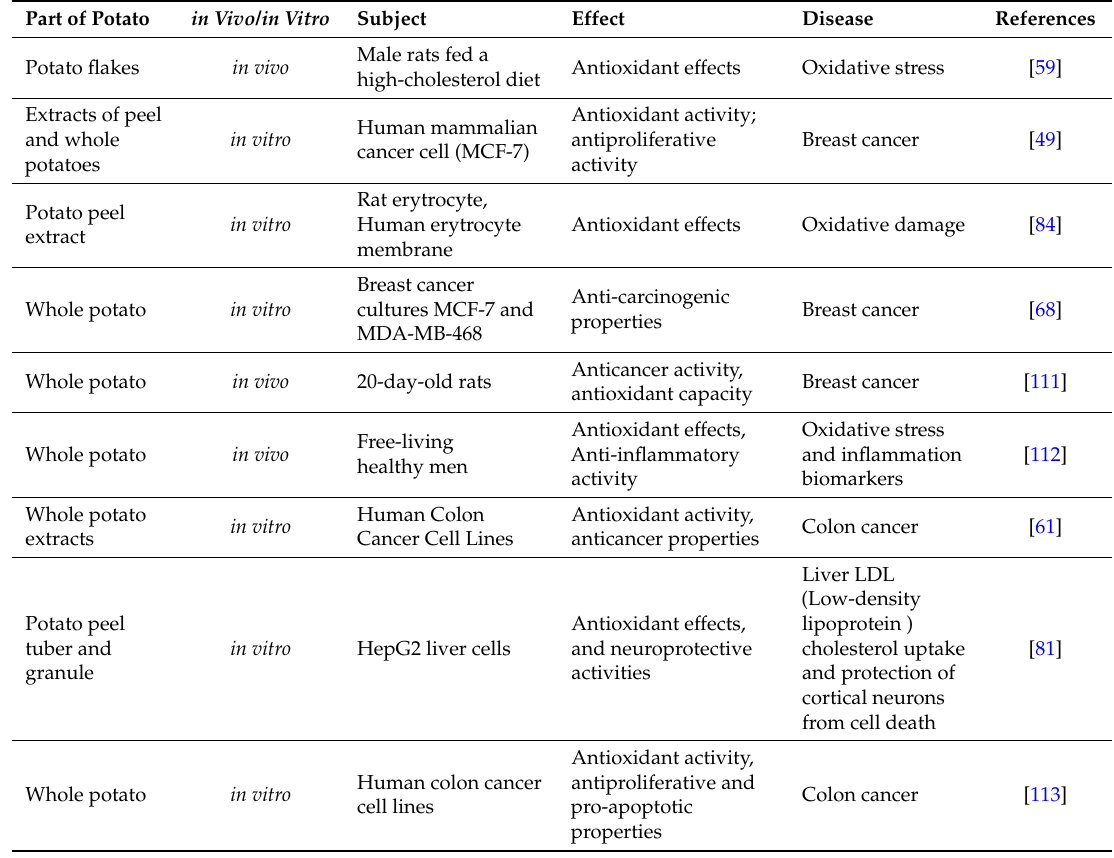
Table 4. Health effects of